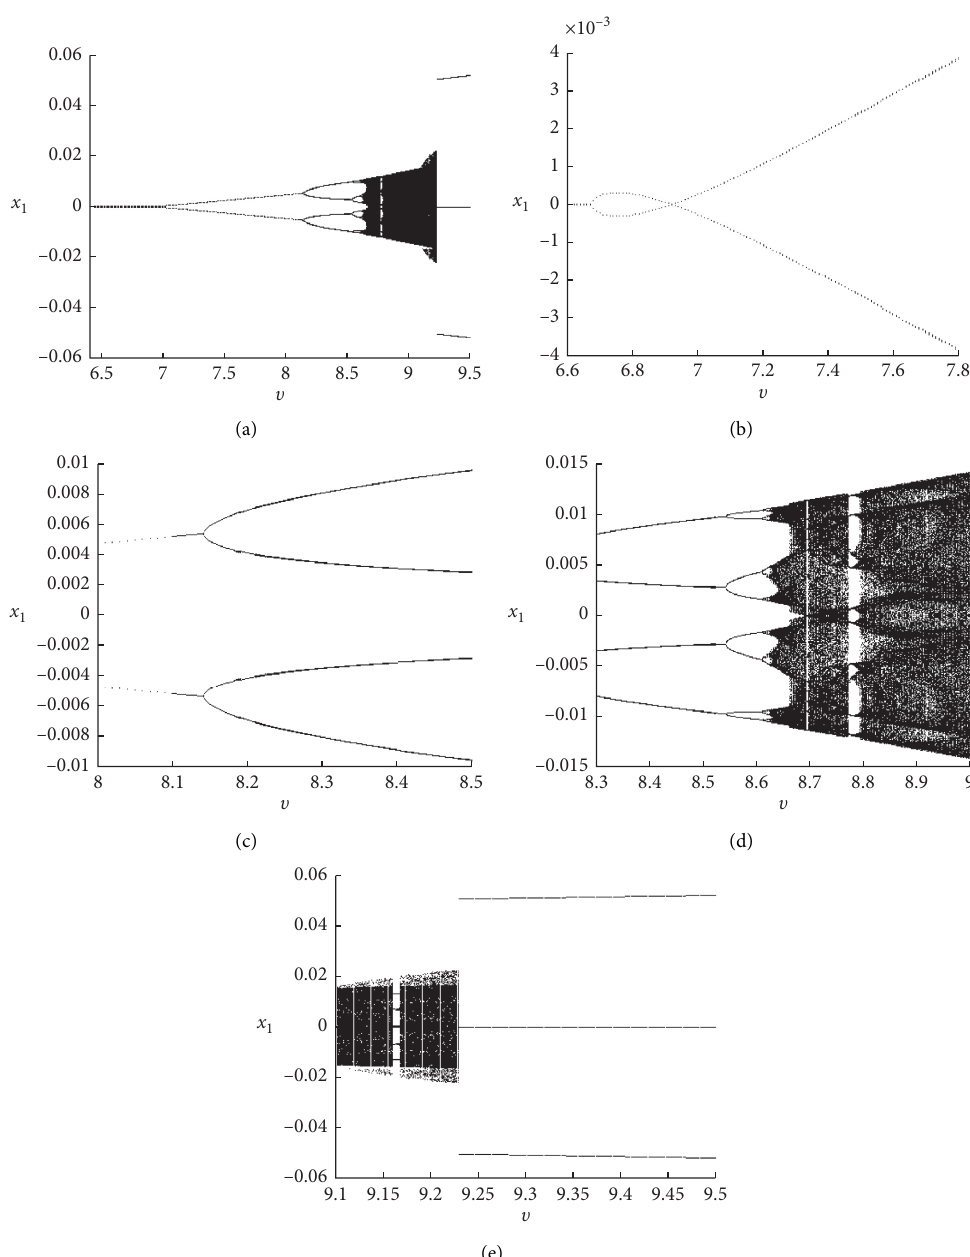
Figure 6: The bifurcation diagrams of the nonlinear system defined by (38) for α � 0 . 005 , β � 0 . 2 , ξ varied. (a) For 6 . 4 ≤ υ ≤ 9 . 5 and (b), (c), (d), and (e) for smaller ranges of υ , showing more